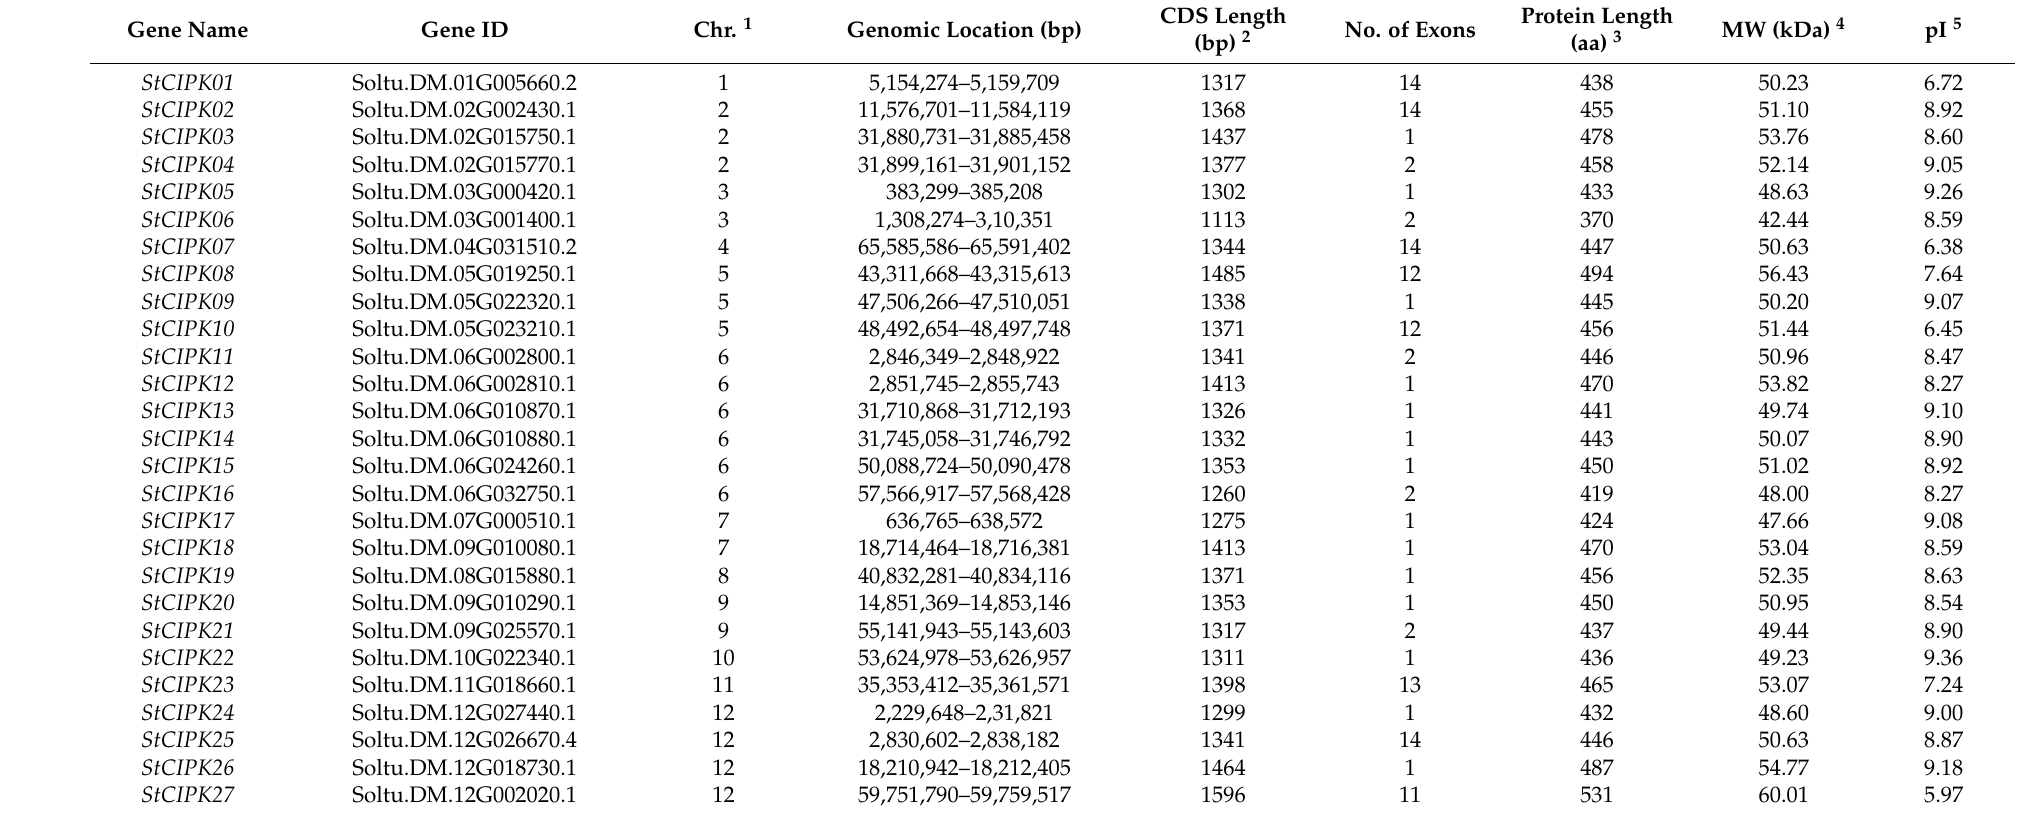
Table 1. Characteristics of StCIPK genes and the encoded